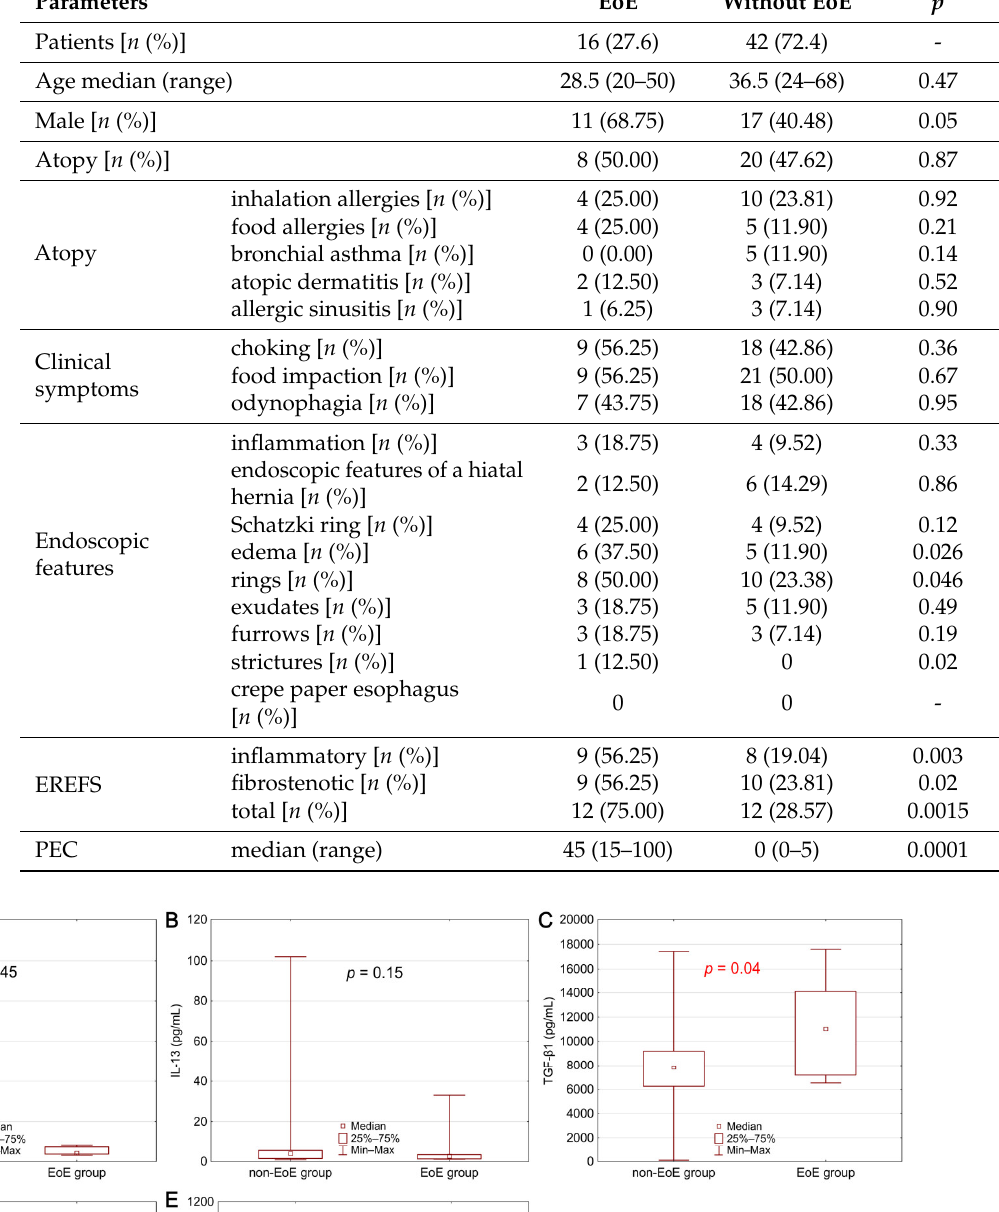
Table 1. Characteristics of the study participants divided into the group with eosinophilic esophagitis (EoE) and without EoE (EREFS—Eosinophilic Esophagitis Endoscopic Reference Score, PEC—peak